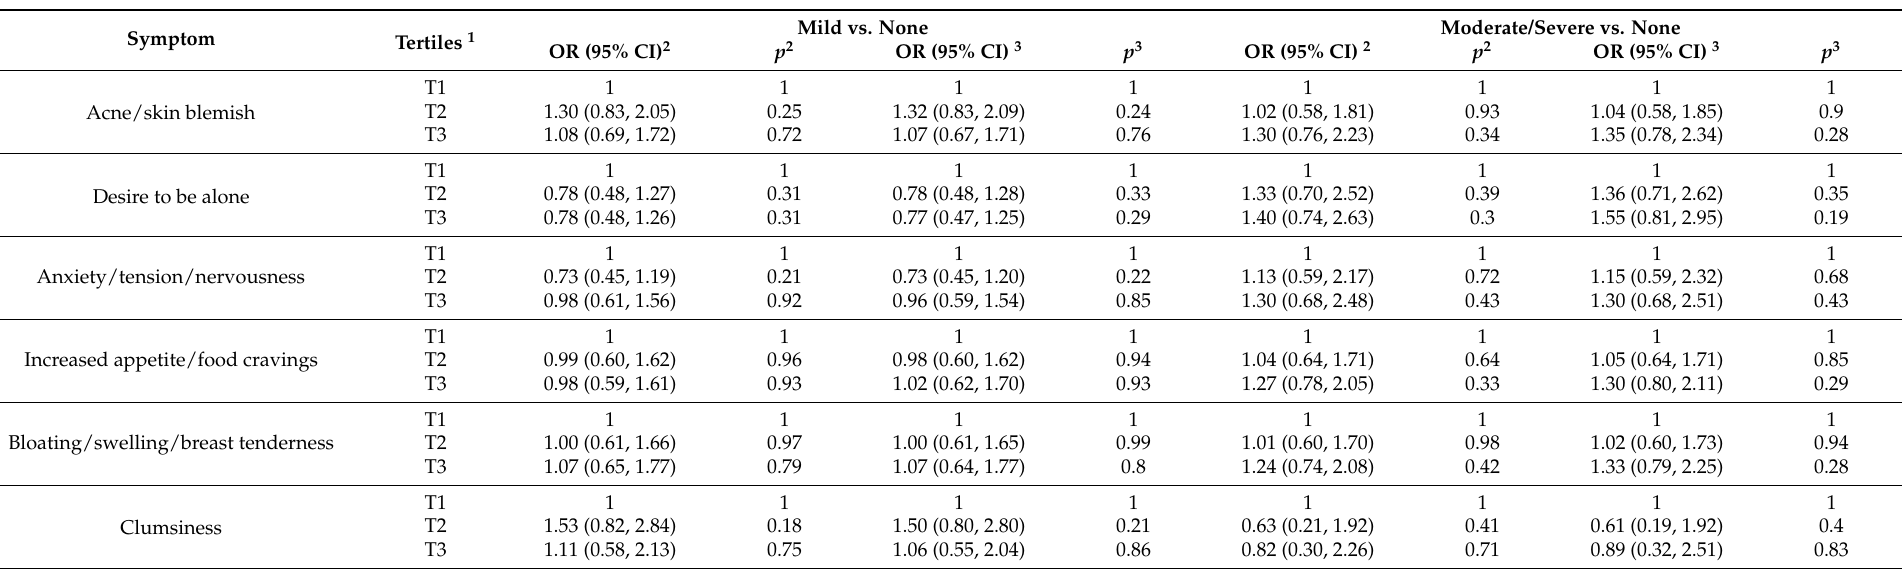
Table 7. Unadjusted and adjusted Odds Ratios and 95% CIs for the association between tertiles of plasma zeaxanthin and premenstrual symptoms.